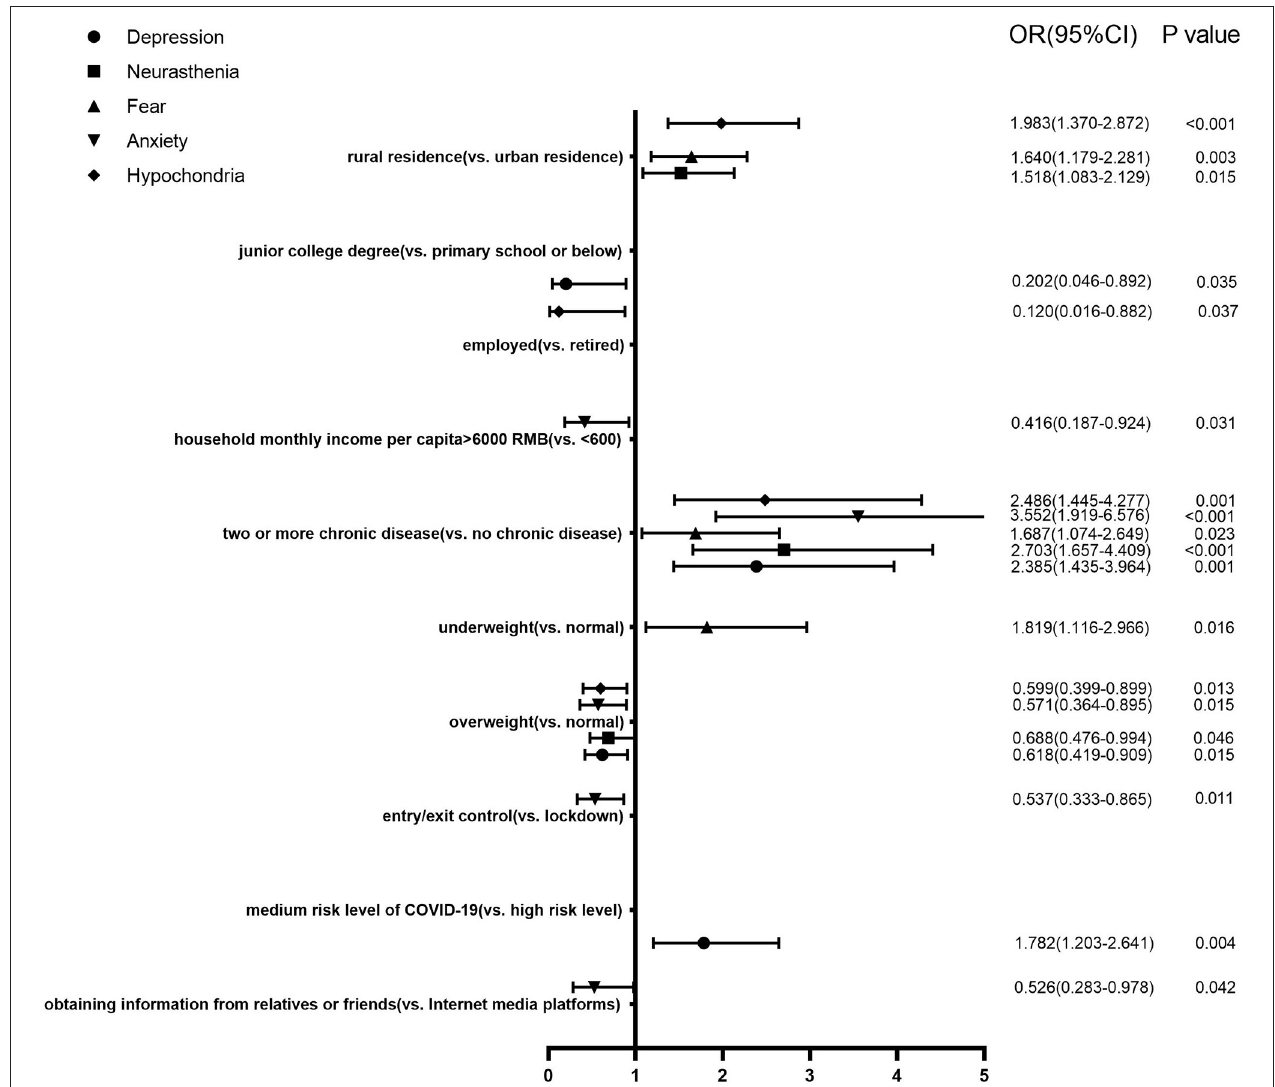
FIGURE 1 | Factors associated with scores of the five sub-scales of the PQEEPH: a multivariable analysis ( N =